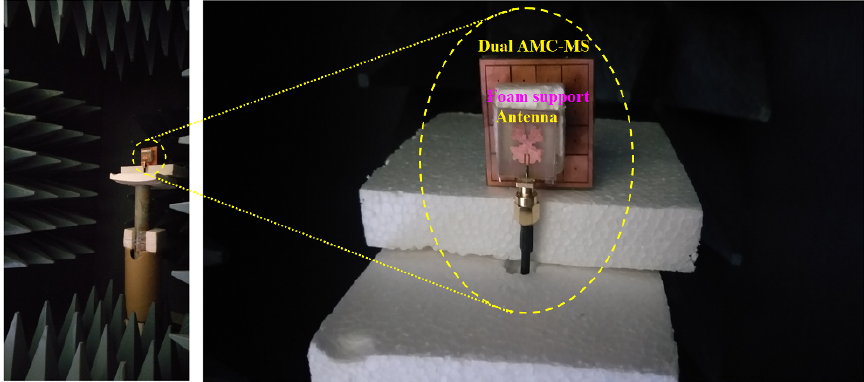
Figure 16. Far-field measurement setup of proposed antenna configuration inside anechoic chamber.